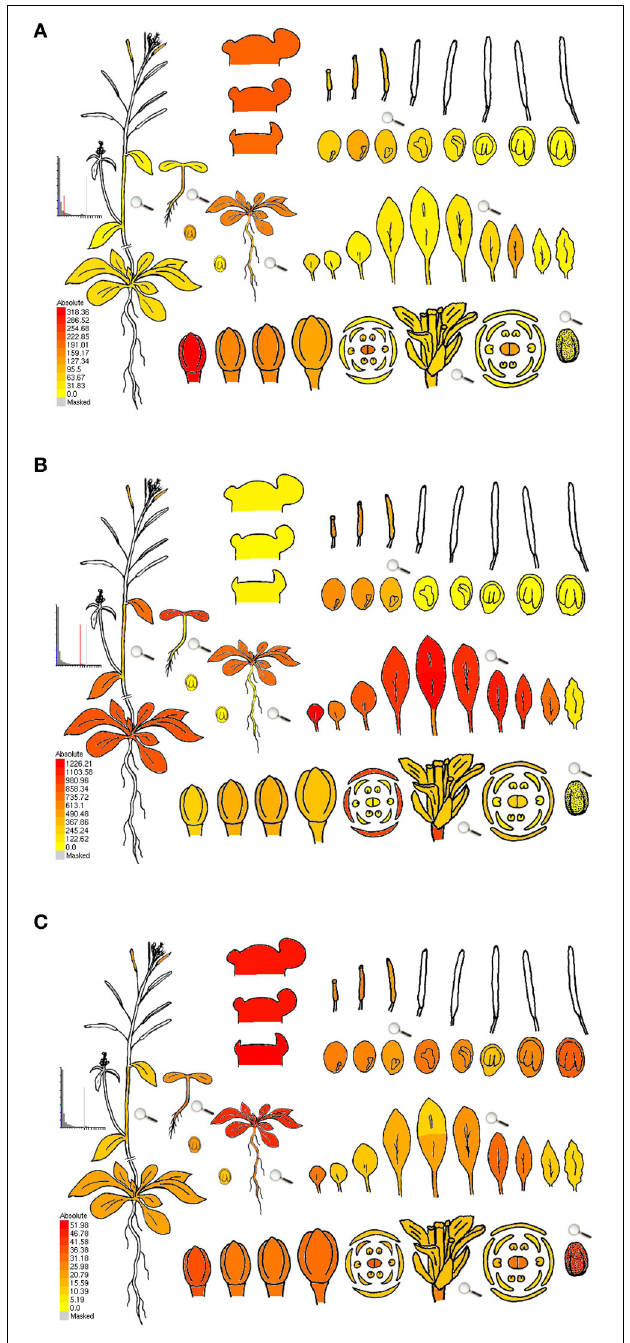
FIGURE 1 | eFP browser view of gene expression during Arabidopsis development. (A) DMC1 (At3g22880), encoding a well-characterized meiotic recombinase, confirmed as up-regulated in isolated meiocytes vs. seedlings in Arabidopsis and in maize ( > 5-fold and > 1000-fold respectively). (B) NDF1 (At1g15980), encoding a chloroplast NAD(P)H dehydrogenase subunit, identified as more than 35-fold up-regulated in seedlings vs. isolated meiocytes in Arabidopsis (and by more than 700-fold in maize homologs). (C) RAD51 (At2g20850), encoding a well-characterized recombinase, operating in both meiotic and somatic tissue; slightly up-regulated in isolated meiocytes vs. seedlings in Arabidopsis and